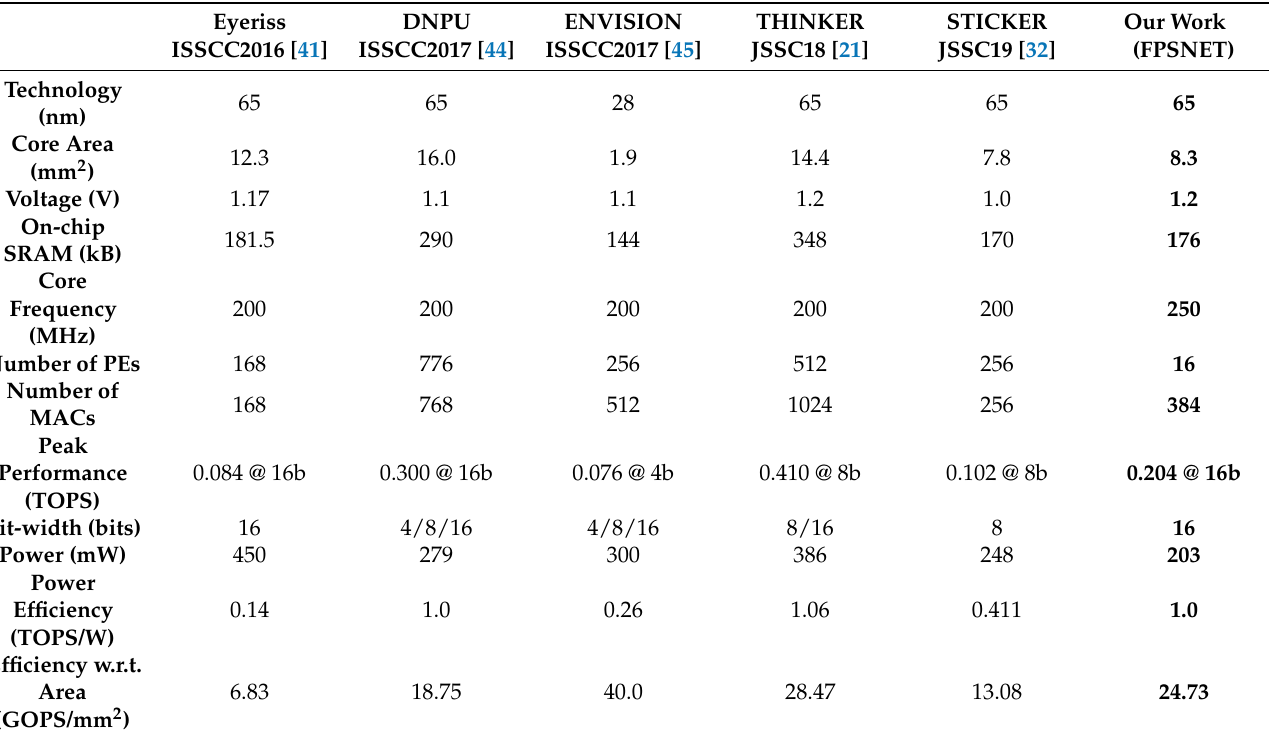
Table 6. Comparison with previous ASIC